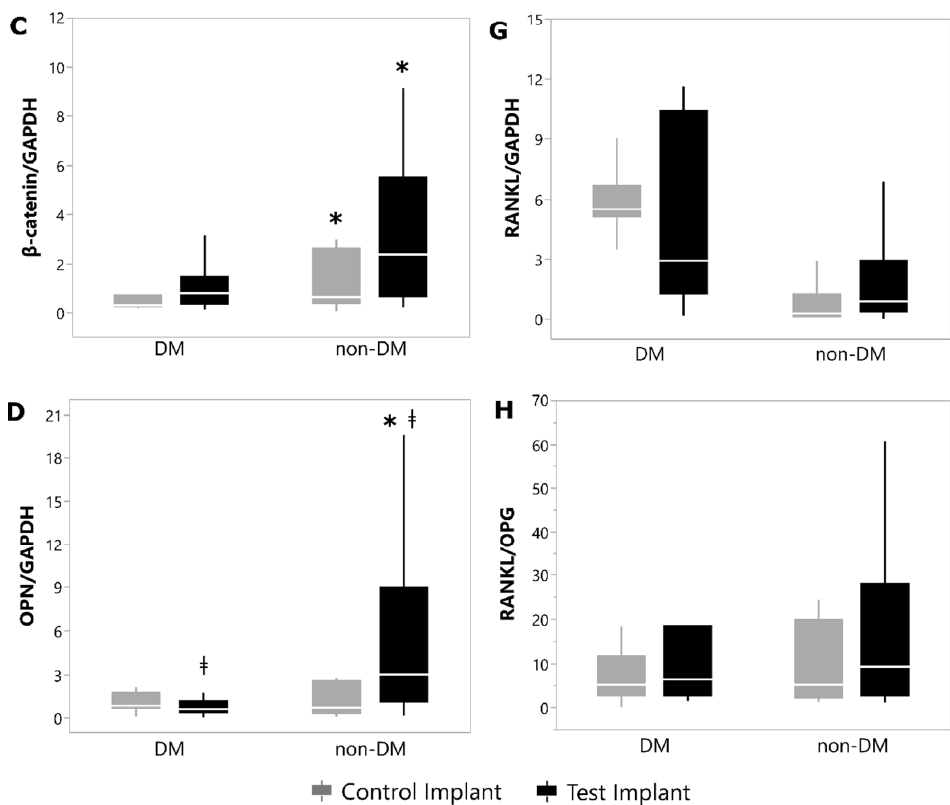
Figure 4. ǂ indicates intra-group statistical differences (Wilcoxon Signed-rank Test; p < 0.05). * indi- cates inter-group statistical differences (Mann–Whitney U Test; p < 0.05). Relative levels of mRNA for: ( A )—RUNX/GAPDH; ( B )—BMP-2/GAPDH; ( C )— β -CATENIN/GAPDH; ( D )—OPN/GAPDH; ( E )—OPG/GAPDH; ( F )—DKK/GAPDH; ( G )—RANKL/GAPDH; ( H